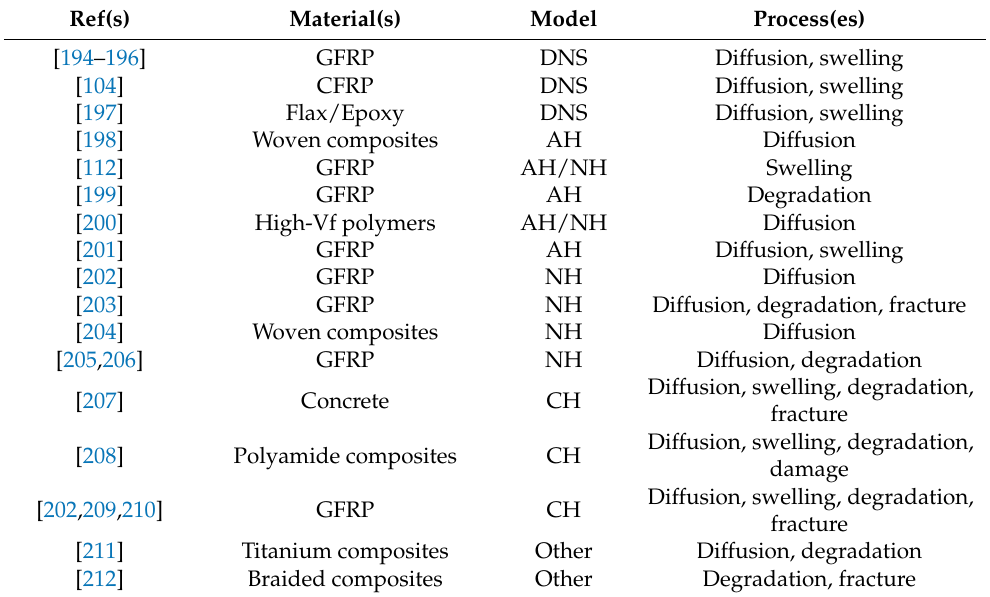
Table 2. A condensed list of recent works modelling ageing in heterogeneous materials at multiple scales. Model abbreviations: DNS (Direct Numerical Simulation), AH (Analytical Homogenization), NH (Numerical Homogenization), CH (Computational